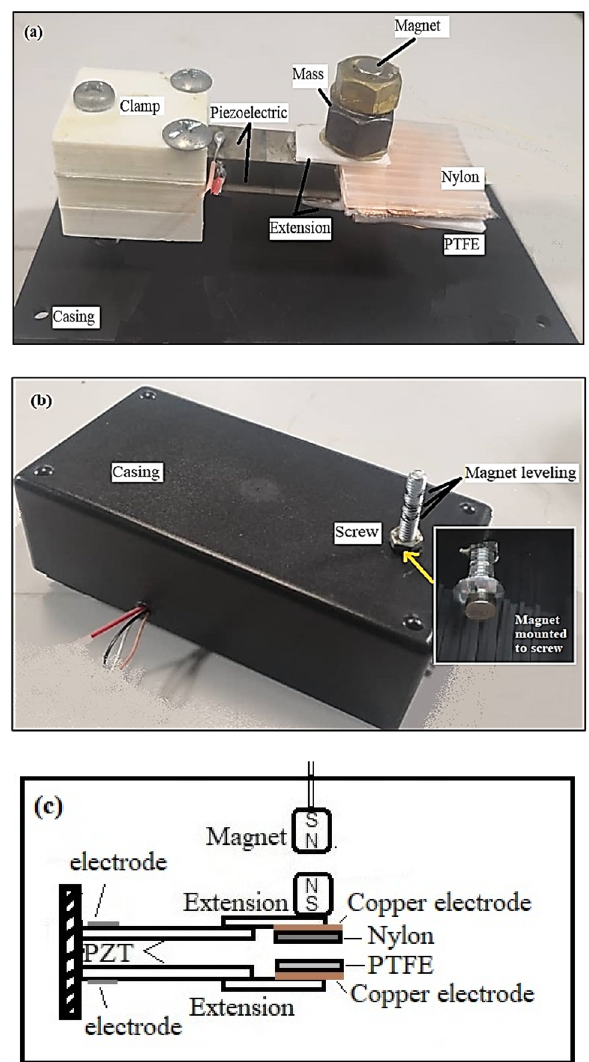
Figure 2. ( a ) Interior image ( b ) exterior image and ( c ) schematic diagram of MT-HPTEH